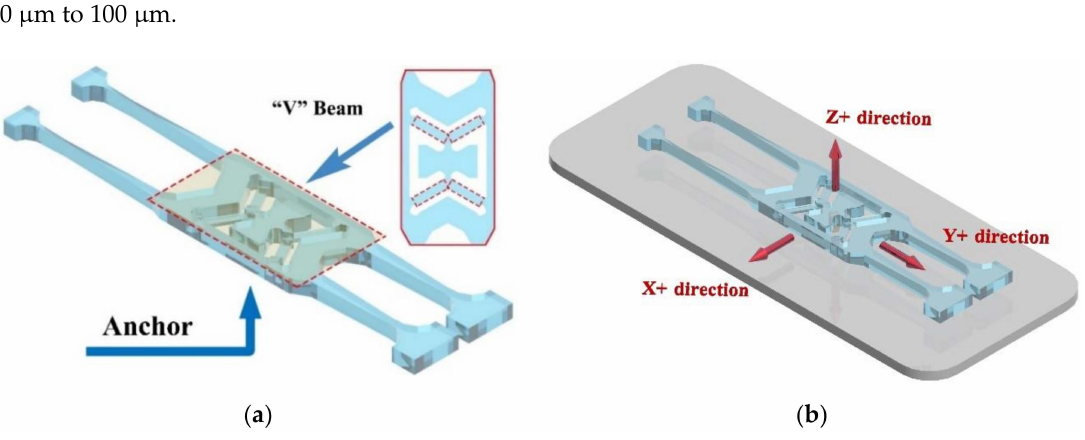
Figure 12. ( a ) Sensitive component model of the gyroscope. ( b ) Three of the six shock directions of shock